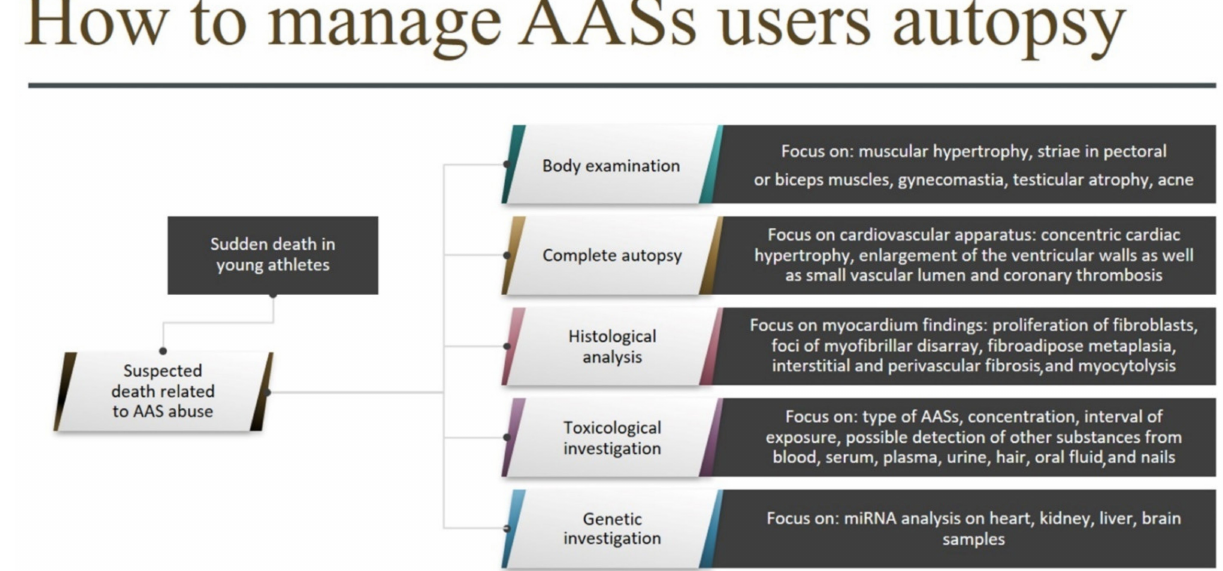
Figure 4. Investigative protocol for cases of suspected death related to AAS